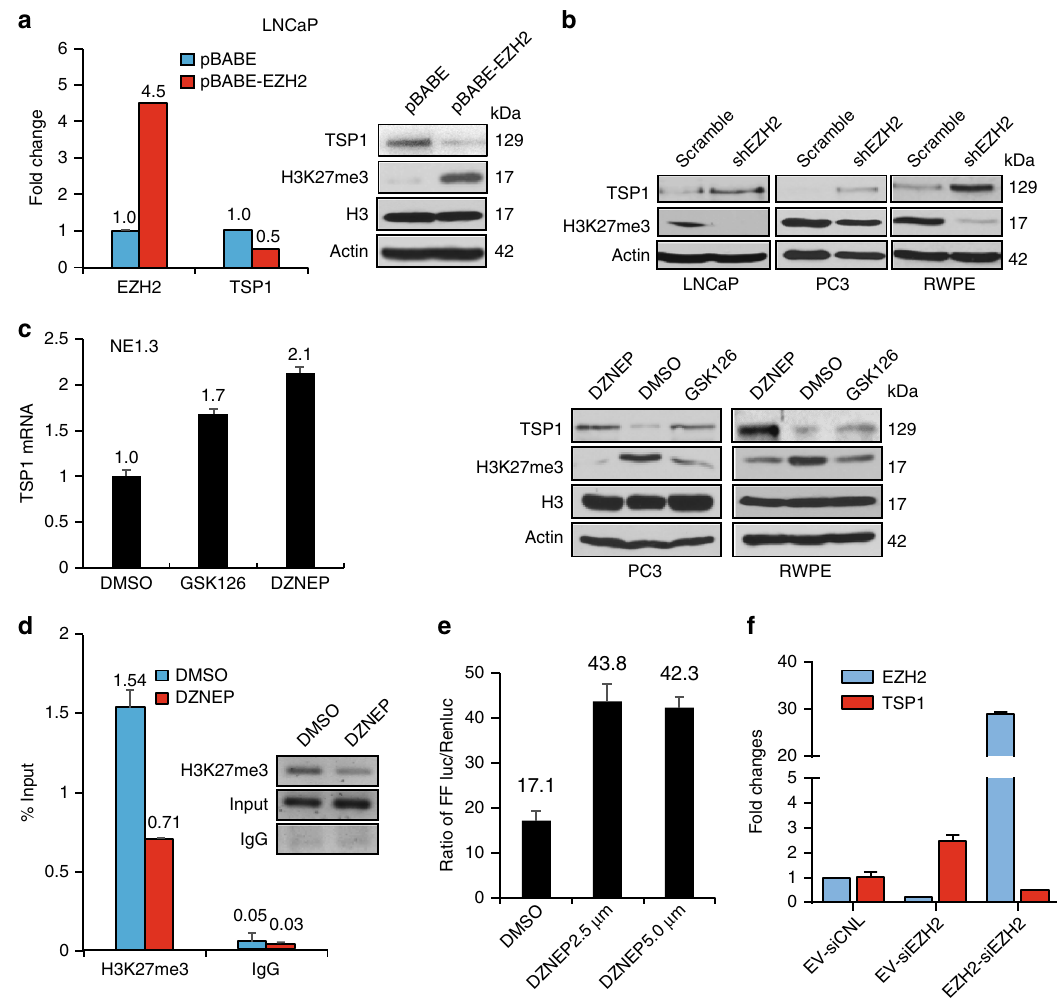
Fig. 5 TSP1 is a novel EZH2 epigenetic target in prostate cancer cells. a , b Changes in TSP1 expression and H3K27me3 levels upon EZH2 cDNA overexpression ( a ) and shRNA silencing ( b ) in prostate cancer cells. c Marked reduction of H3K27me3 and up-regulation of TSP1 in PC3, RWPE, and NE1.3 cells treated with 5 μ M of EZH2 inhibitor DZNEP or GSK126 for 24 h. d PC3 cells were treated with 2.5 μ M DZNEP or vehicle control (DMSO) for 24 h. A ChIP assay was conducted using IgG control or anti-H3K27me3 antibody. The level of H3K27me3 mark on TSP1 promoter was presented as % of the inputs ( Y -axis), which was con fi rmed through DNA gel electrophoresis. e PC3 cells were transfected with pGL3 fi re fl y luciferase vector with TSP1 promoter along with a pRL-TK renilla luciferase control vector, then treated with DZNEP 2.5 μ M and 5 μ M for 24 h, followed by Dual-luciferase reporter assay. Plotted on Y -axis are the ratios of fi re fl y luciferase signals vs renilla luciferase control signals in each treatment. f PC3 cells carrying an empty vector or siRNA-resistant EZH2 cDNA were transfected with control siRNA (siCNL) or siEZH2. Total RNA was extracted 72 h after siRNA treatment, and RT-qPCR for EZH2 and TSP1 was carried out, using GAPDH as the internal control. Plotted on Y -axis are average fold changes with